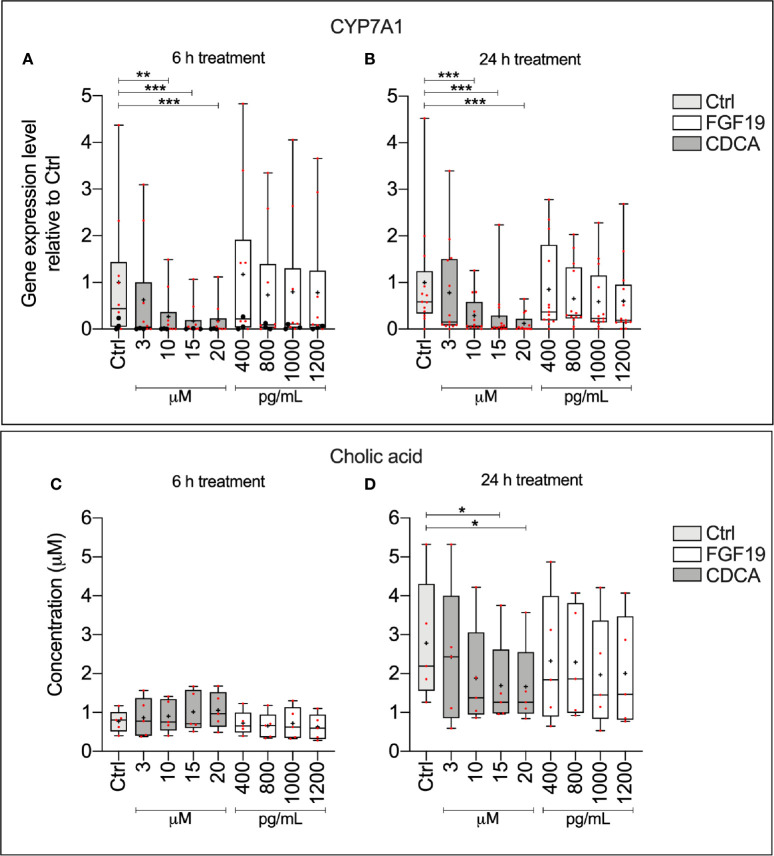
Chenodeoxycholic acid (CDCA), but not recombinant FGF19, downregulated bile acids (BA) synthesis in primary human hepatocytes. (A, B) CYP7A1 mRNA expression (24 h, n = 13; 6 h, n = 10) and (C, D) cholic acid (CA) concentration (24 h, n = 5; 6 h, n = 5) in cell medium following treatment with FGF19 or CDCA at various concentrations for 24 h or 6 h. Data is presented as box-plot showing interquartile range (IQR) (box) and min-max (bars) with median marked with a line, red dots are the individual values, black dots in (A) represents RNA from donors that were also used for RNA sequencing. The plus sign represents mean value. Friedman test was used to assess differences between control and treatments and Dunn’s multiple comparison test was used post hoc. *p < 0.05, **p < 0.01, ***p < 0.001.